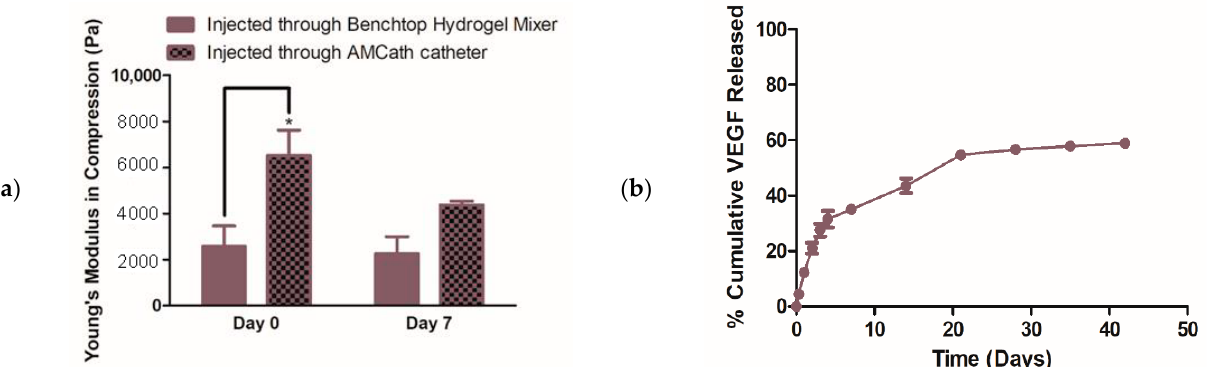
Figure 6. ( a ) Young’s modulus at day zero and day seven of hydrogels formed either via injection through the Benchtop Hydrogel Mixer (BHM) or via injection through AMCath connected to a syringe pump. ( b ) % cumulative VEGF release from nano-VEGF-HA-TA hydrogels formed via AMCath injection based on a dose of 50 ng VEGF per hydrogel sample. * p < 0.05. ( n = four technical replicates for mechanical testing, n = three technical replicates for release testing).